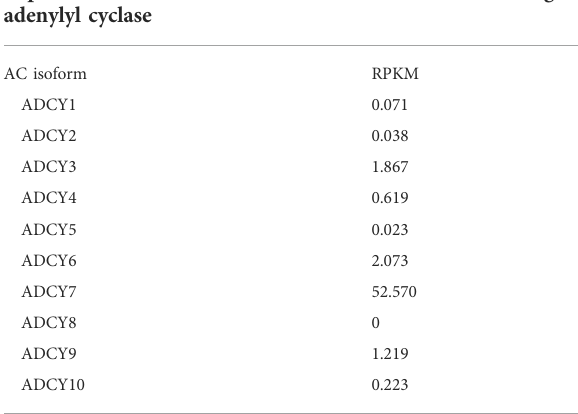
TABLE 2 Microglia were isolated at autopsy from parietal lcortex of 39 human subjects. RNASeq was performed on total RNA extracted from fl ow cytometry-sorted cells. Values represent median microgliaexpressionlevels(RPKM,readsperkilobaseoftranscriptper million reads mapped). Galatro et al.,